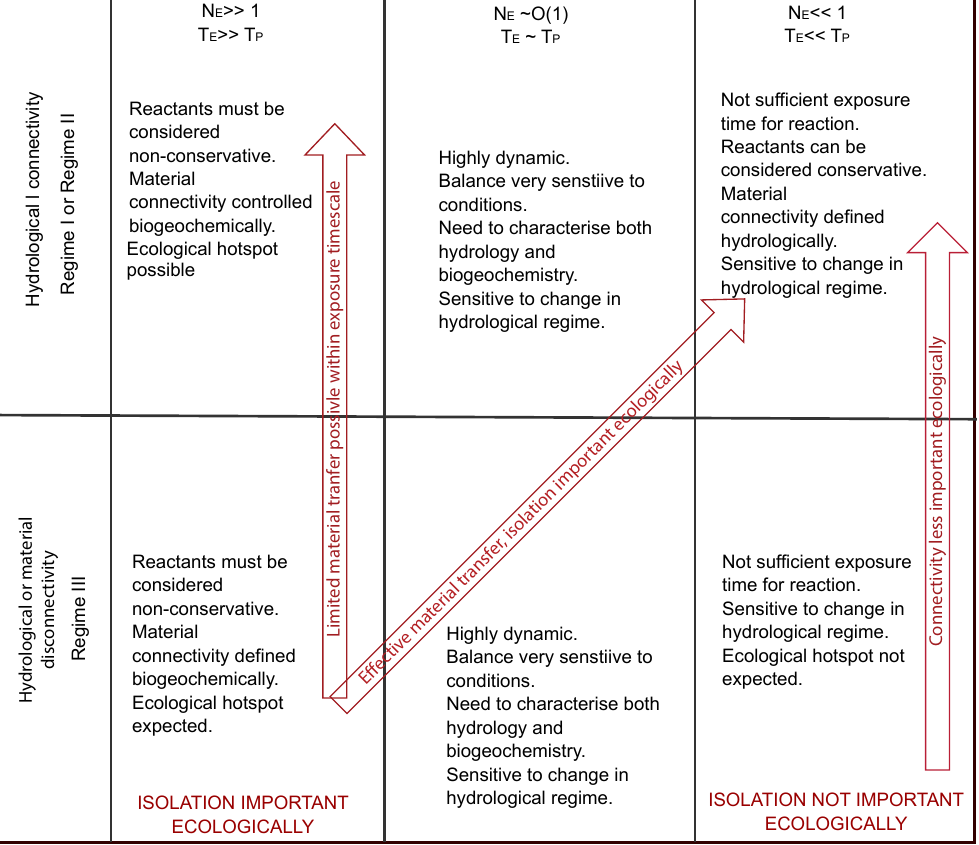
connected and isolated) and processing timescales determines the ecological signficance of the period of isolation and the regime shift.